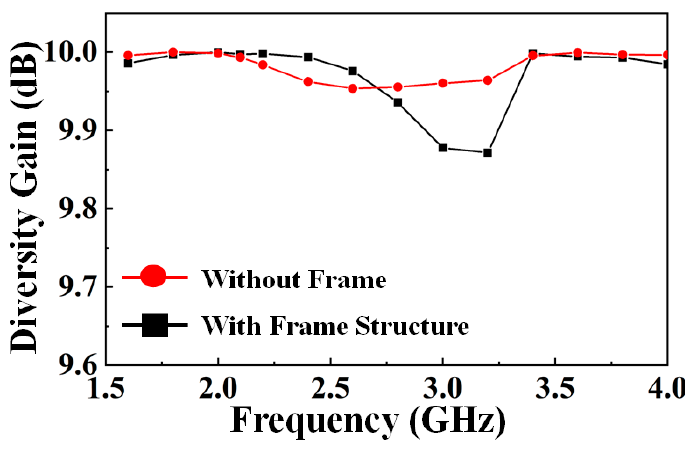
Figure 8. Diversity gain with and without frame structure.